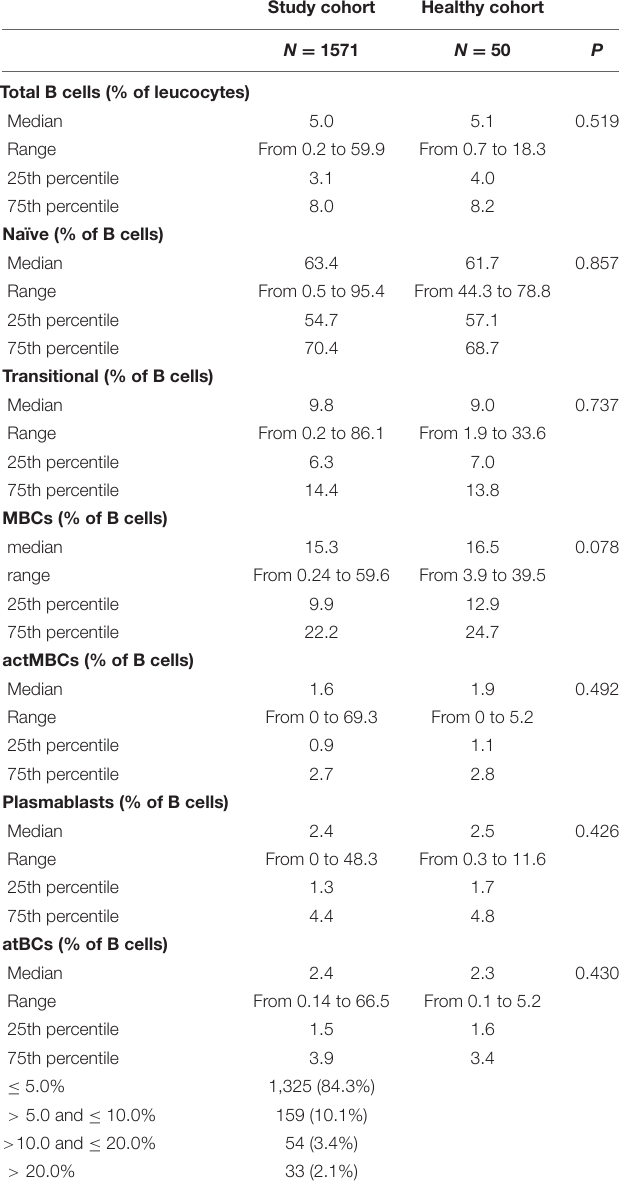
TABLE 2 | Statistics of the B-cell subsets on the overall flow cytometric